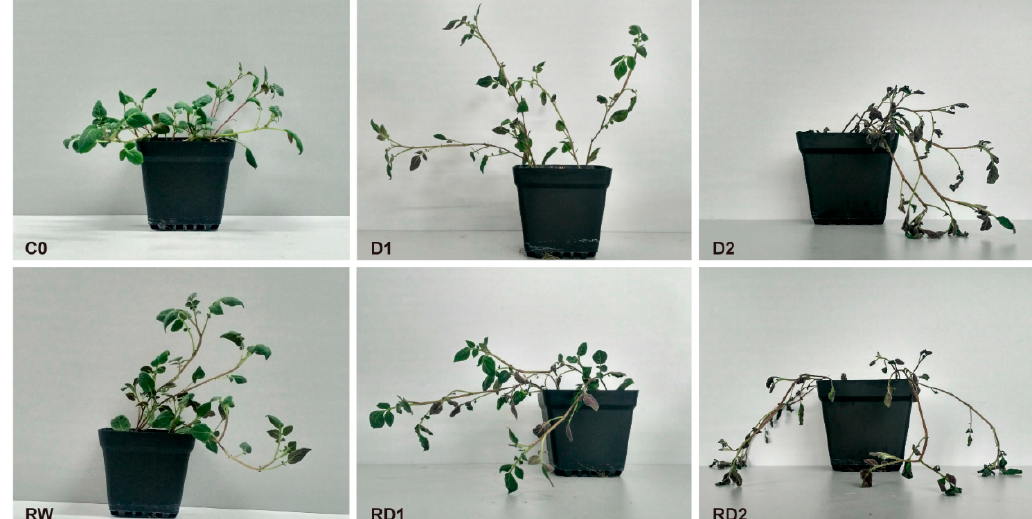
Figure 9. Phenotypes of Jancko Sisu Yari (JSY) under drought stress, rehydration and re-dehydration. C0 is the control of normal watering; D1 is the first mild drought stress; D2 is the first severe drought stress; RW is one day after rehydration; RD1 is the mild re-drought stress; and RD2 is the severe re-drought stress.